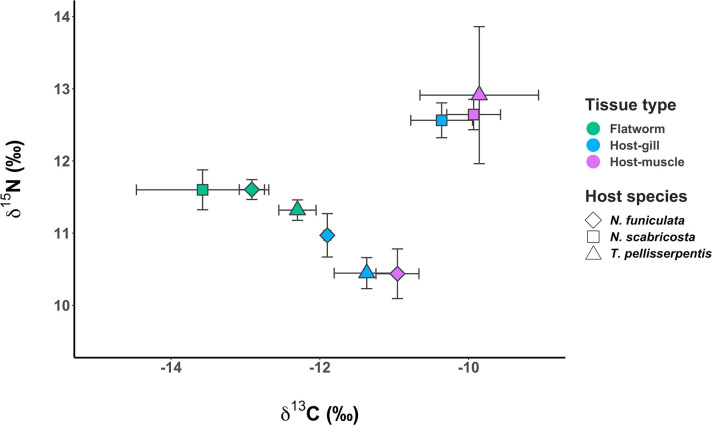
Stable isotope analysis of flatworm and snail tissues.Tissue δ 13C and δ 15N of flatworms and their snail host species: Nerita funiculata (diamond), N. scabricosta (square), and Tegula pellisserpentis (triangle). Different colors represent tissues sampled from flatworm (emerald green), snail gill (light blue), and snail mantle and foot muscle (purple pink). Sample size was n = 4−8 for each snail species × tissue category. Error bars indicate 1 SE.